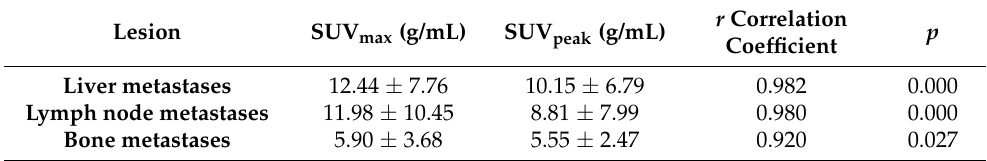
Table 4. Correlation between SUVmax and SUVpeak of neuroendocrine metastases.